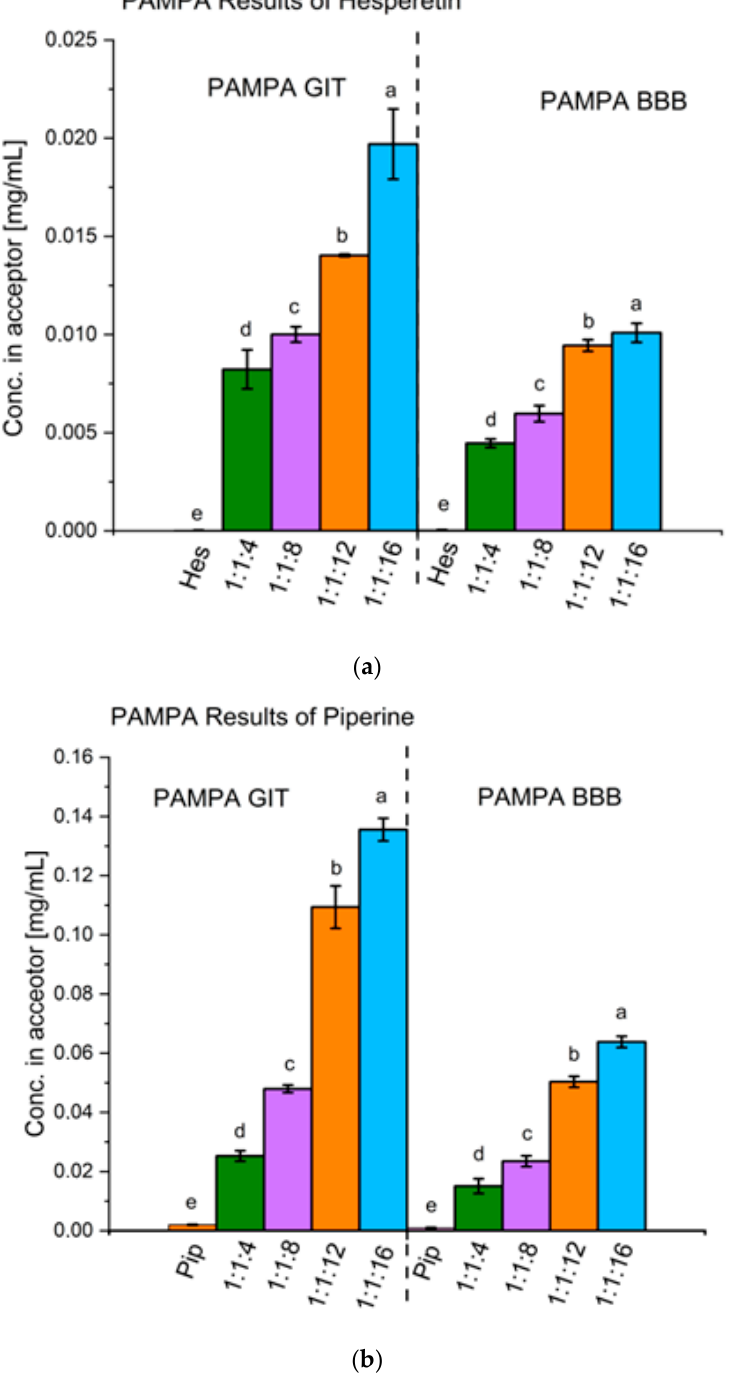
Figure 5. The results of the in vitro permeability assay for hesperetin ( a ) and piperine ( b ). Amorphous systems were named as a mass ratio of individual components, Hes:Pip:VA 64 (Hes: hesperetin, Pip: piperine, and VA 64: PVP VA 64). The statistically significant values are presented as a–e, with “a” being the highest value ( p < 0.05).